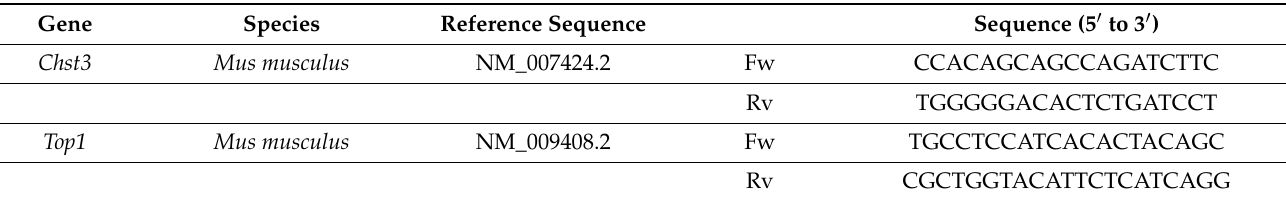
Table 2. Probes used for sorted nuclei